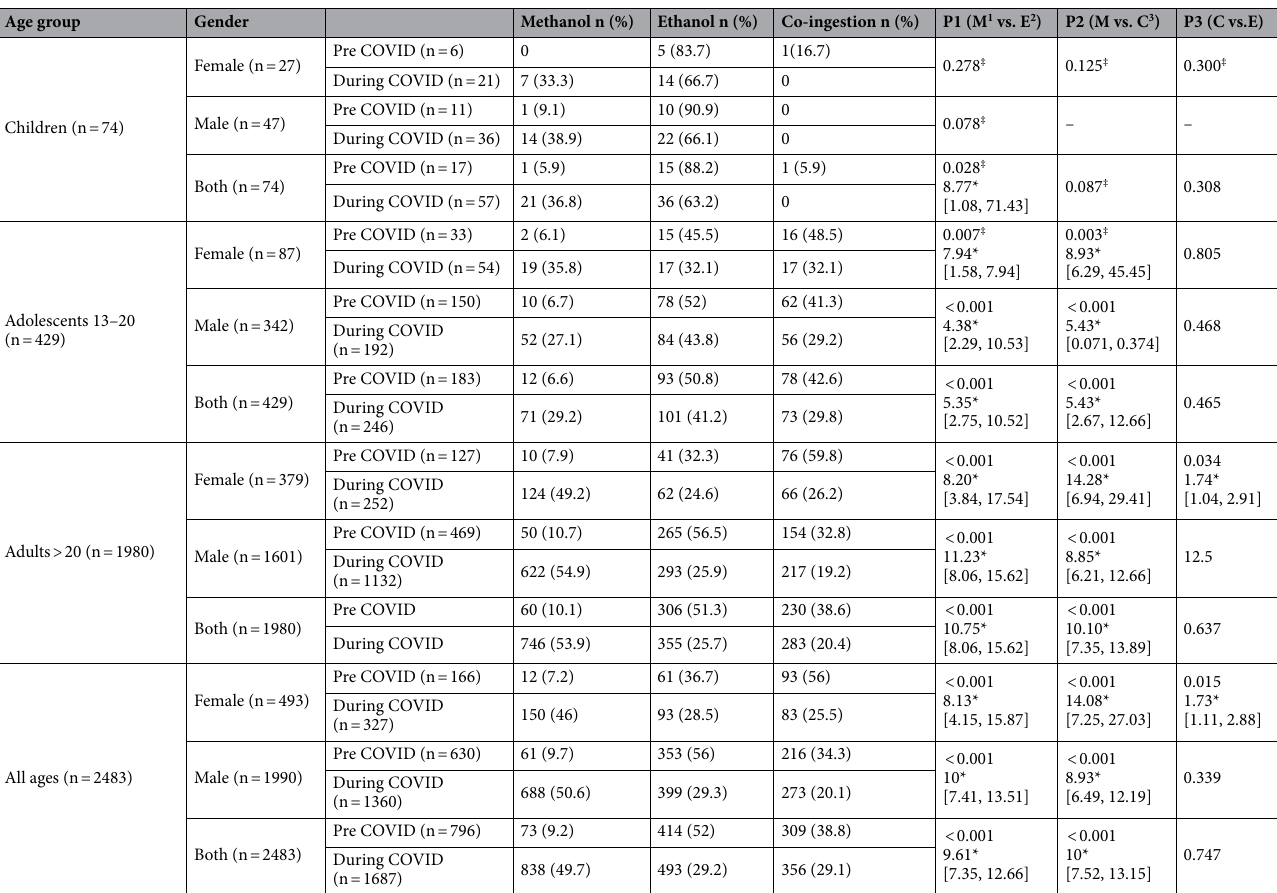
Table 1. Number of alcohol intoxications and patients’ characteristics before and during COVID-19 outbreak (n = 2483). ‡ Applying Fisher’s Exact test, *OR (95% CI), M 1 (Methanol), E 2 (Ethanol), C 3